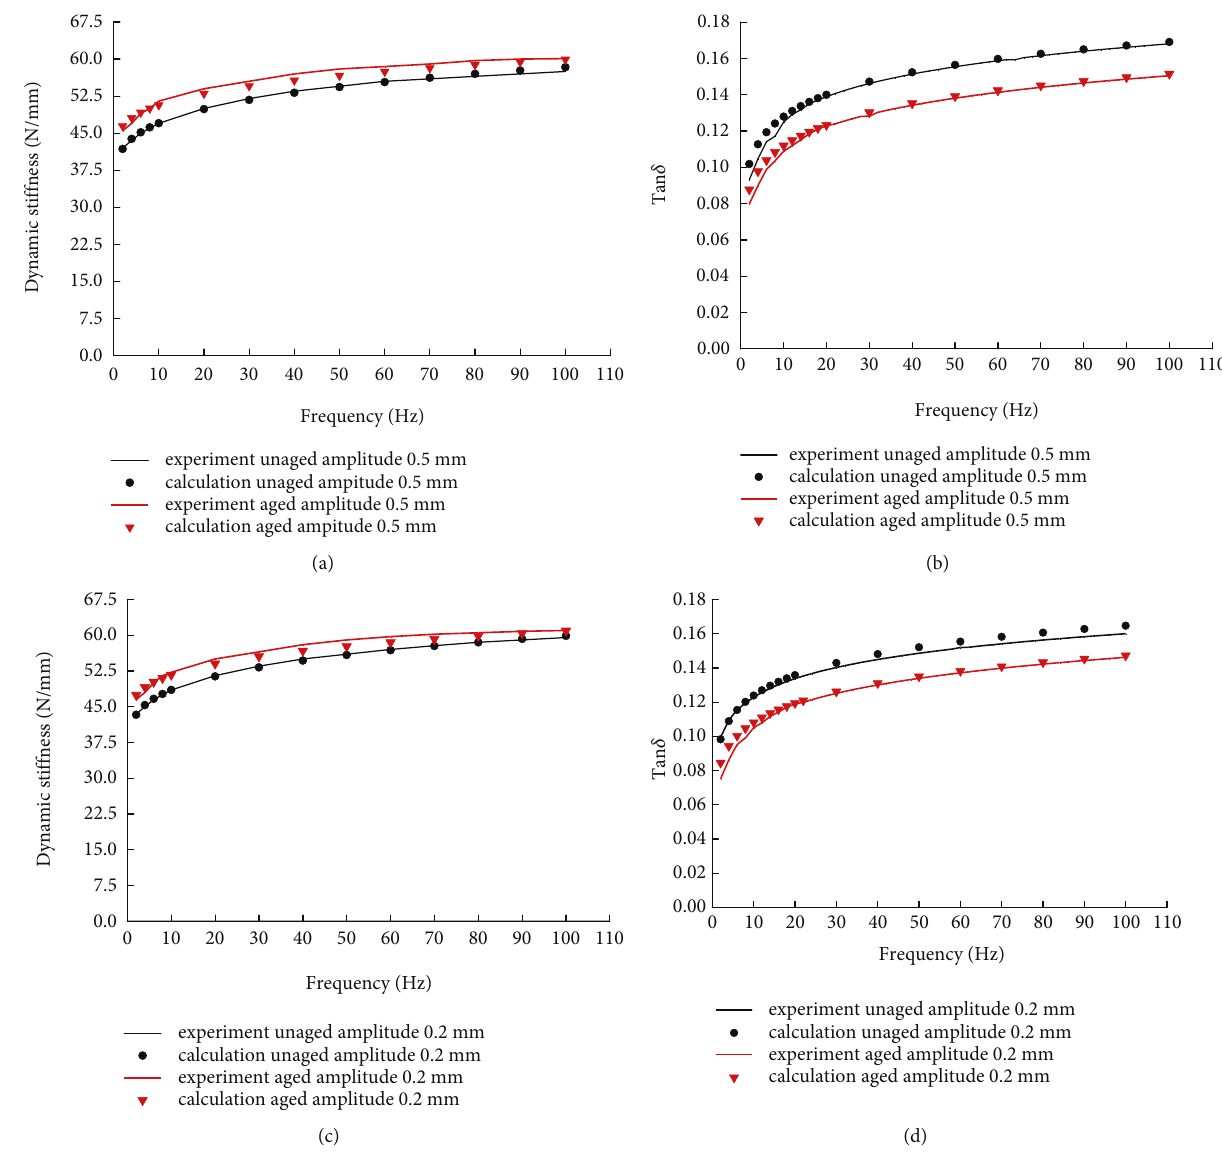
Figure 17: Dynamic sti ff ness and loss factor of the RIP under the di ff erent amplitudes. (a) Dynamic sti ff ness under the amplitude of 0.5mm, (b) loss factor under the amplitude of 0.5mm, (c) dynamic sti ff ness under the amplitude of 0.2mm, and (d) loss factor under the amplitude of